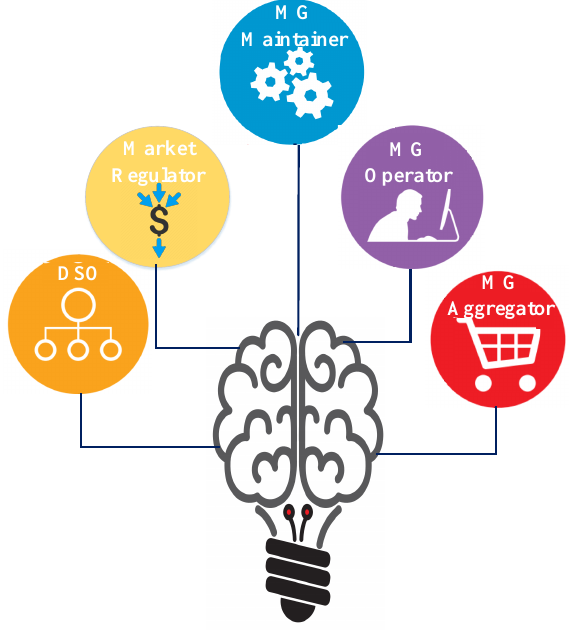
Figure 2. EMS optimization function